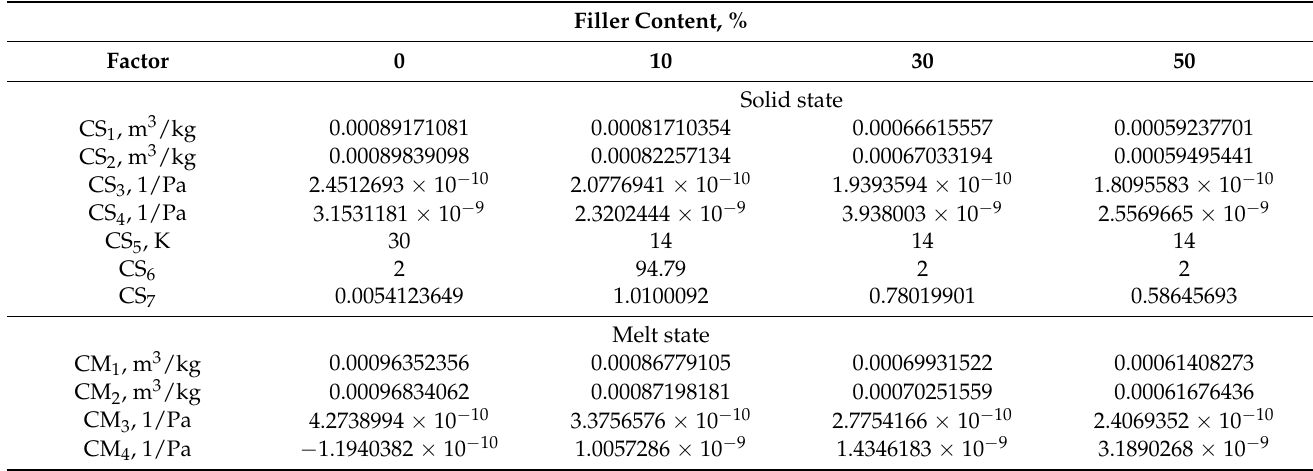
Table 1. Renner equation coefficients depending on the filler content.